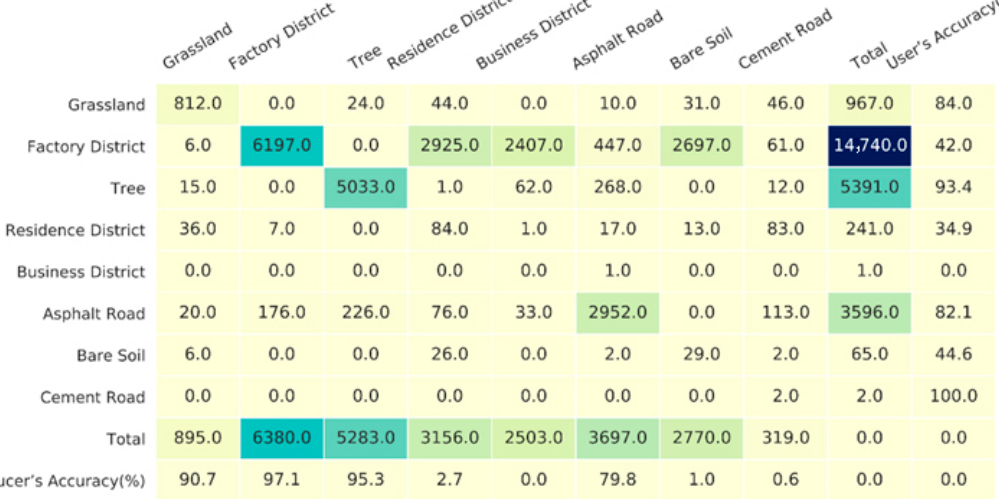
Figure 5. Confusion matrix of classification results when only single-angle images according to one angle served as the input data.